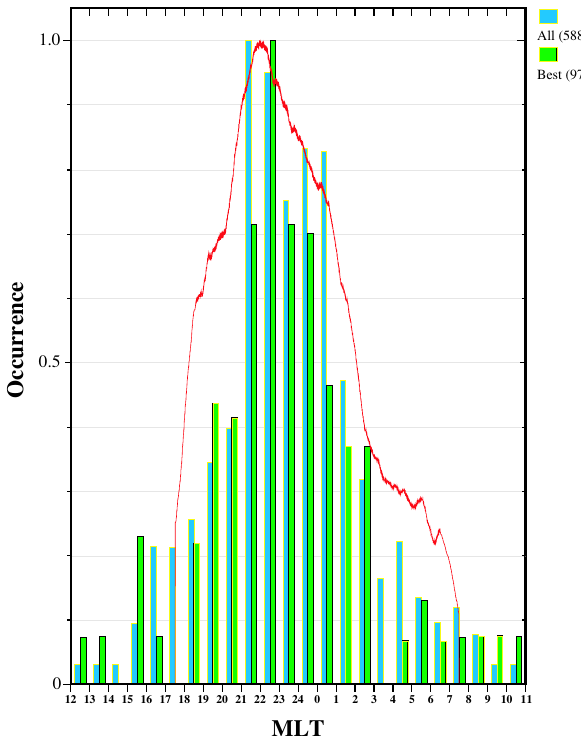
Fig. 6. The distribution of the occurrence of the inverted-V’s in MLT shows the maximum occurrence in the pre-midnight sector (21–23 MLT) where also other auroral phenomena are most often seen. The red curve presents the occurrence of auroral arcs in MLT according to Syrj¨asuo and Donovan (2004).